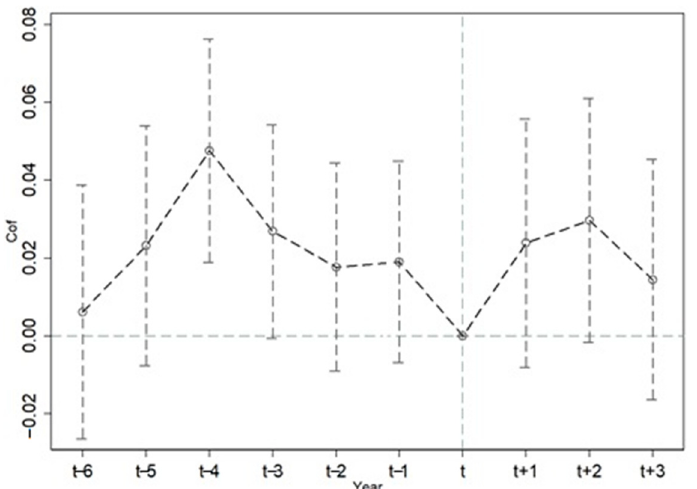
Figure 3. Common trend of in situ urbanization